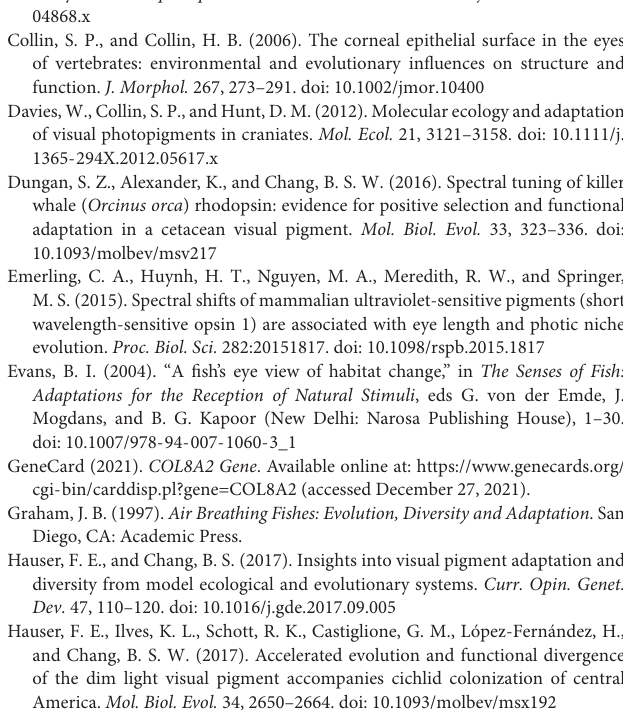
Supplementary Figure 1 | Phylogenetic tree of 13 mtDNA constructed by